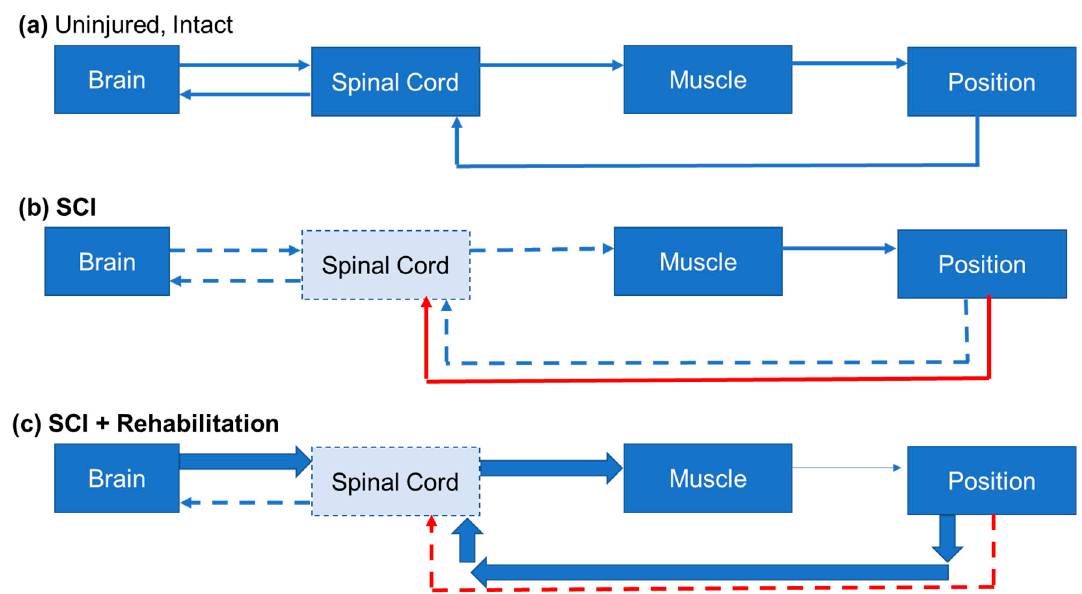
Figure 3. Motor and Sensory Input Through the Spinal Cord. This figure depicts a simplified model of motor output and sensory feedback used to guide movement in the intact CNS ( a ), after SCI ( b ), and during rehabilitation ( c ). ( a ) The final steps of motor planning involve a signal being sent from the motor cortex down to the motoneurons in the spinal cord. These motoneurons send signals to neuromuscular junction causing the appropriate muscle to contract and guide the limb to the final position. Feedback from the periphery regarding the final position gets sent back to the spinal cord. The spinal cord uses this information to refine the local connections and sends that information to brain regions involved in motor refinement, such as the cerebellum. ( b ) After injury, the corticospinal neurons lose some of their connections to the spinal cord (dashed lines), and the cord itself loses motoneurons. This results in a weaker signal to the muscle and mobility problems. Additionally, increased and maladaptive sensory input from primary sensory neurons, like the nociceptor, (red arrows) causes LTP related to central sensitization in chronic pain and noise to enter the system making refinement difficult. The sensory information has weakened connection to the brain. ( c ) Rehabilitation harnesses LTP (Figure 1) by forcing descending input from the brain, and sensory input from the periphery, to strengthen and refine connections withing the cord and motor cortex to regain mobility and decrease nociceptive input.